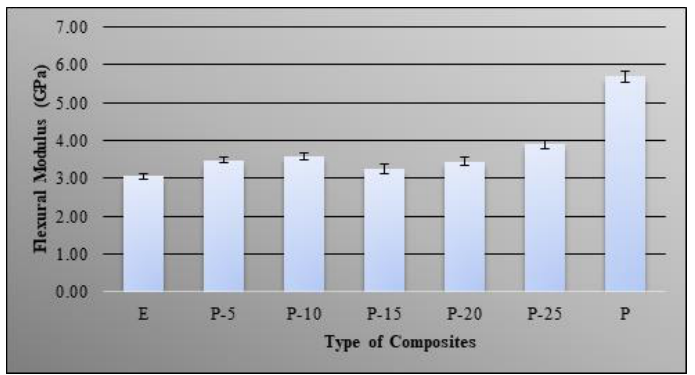
Figure 6. Flexural modulus of bio-phenolic/epoxy blends, neat epoxy, and bio-phenolic